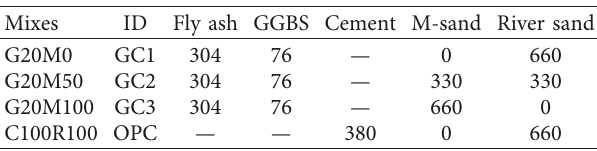
Figure 2: Stress-Strain curve for (a) conventional concrete and (b) geopolymer concrete. (c) Failure patterns of CC and GC were tested under uniaxial compression. Table 3: Details of mix proportions of concrete specimens.